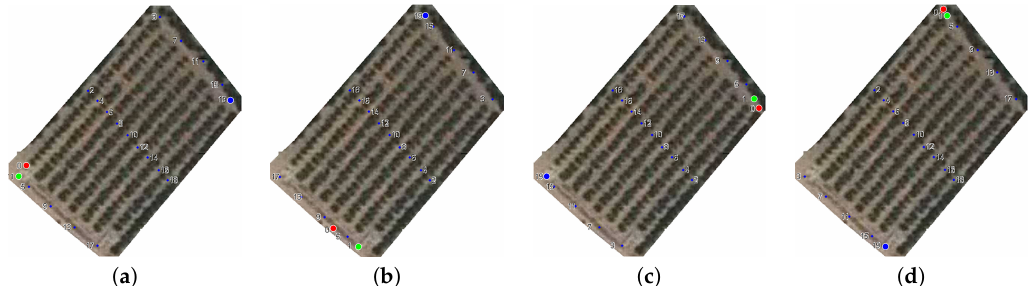
Figure 9. Intermediate points (numbered blue dots) for four different configurations depending on the robot initial position (red circle). The robot must move first to the closest corner (green circle), and then, it must navigate trough the intermediate points (small numbered circles) in order to achieve the last position in the opposite corner (big blue circle). ( a ) robot placed in the upper-left corner, ( b ) robot placed in the bottom-left corner, ( c ) robot placed in the bottom-right corner, ( d ) robot placed in the upper-right